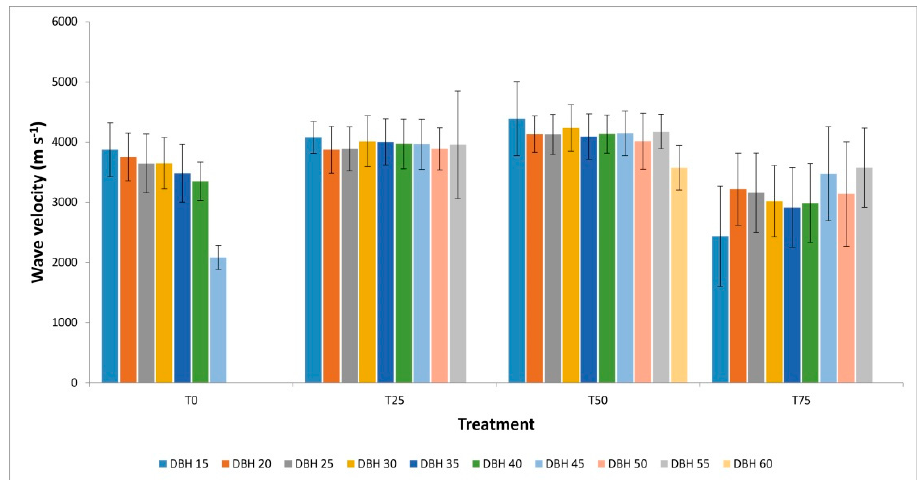
Figure 3. Wave velocity in relation to the diameter classes for each intensity of thinning. DBH: diameter at breast height. For Control, F 6;191 = 3.371; p = 0.006; for T25, F 8;189 = 0.658; p = 0.728; for T50, F 9;188 = 1.600; p = 0.118; for T75, F 8;189 = 2.330; p = 0.021.